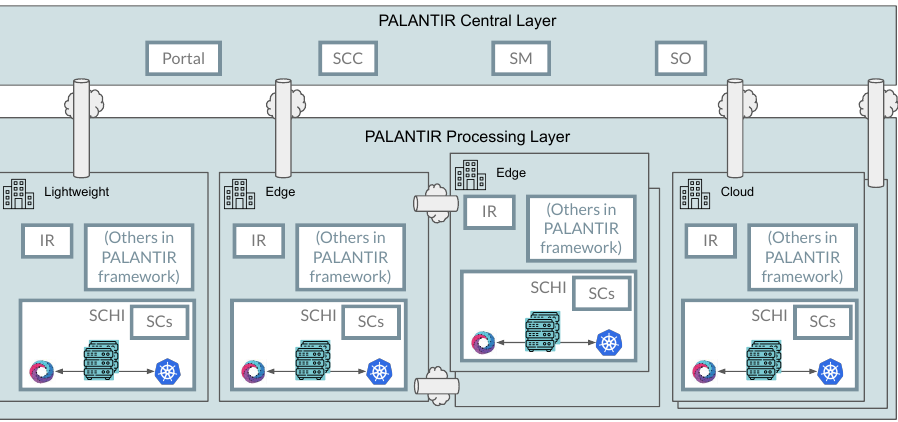
Figure 2. Deployment models foreseen by